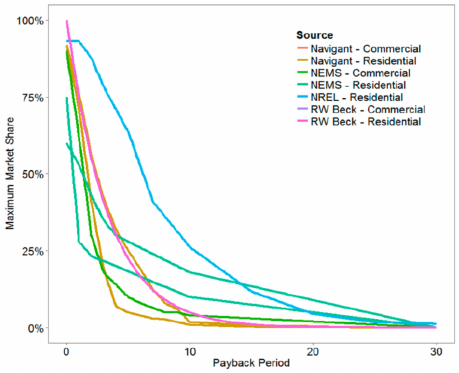
Figure 5. Possible adoption curves as compiled by Sigrin (2016) [9].